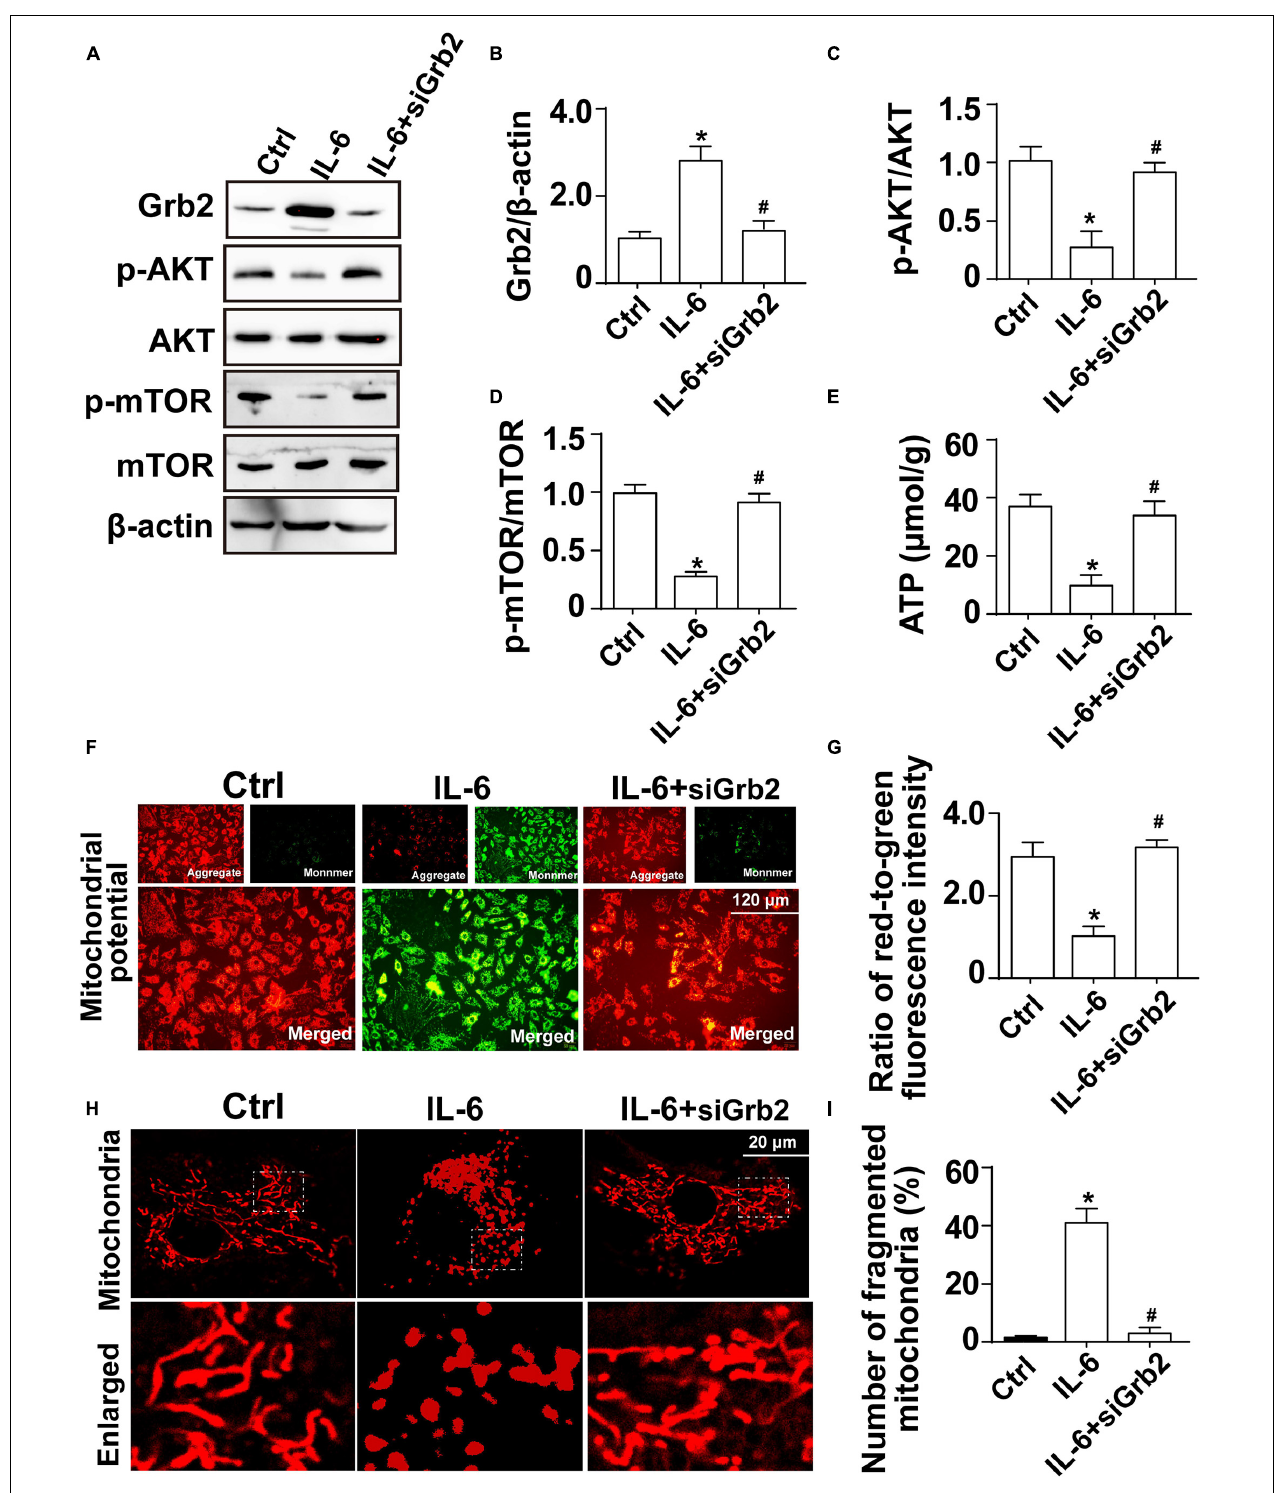
FIGURE 7 | Exogenous IL-6 mediates cardiomyocyte mitochondrial damage and bioenergetics impairment through inhibition of the Akt/mTOR signaling pathway. (A–D) Cardiomyocytes were treated with exogenous IL-6. Then, the protein expression of Grb2, p-Akt, and p-mTOR, respectively, was measured through western blots. (E) The levels of intracellular ATP production were measured through Enhanced ATP Assay Kit. (F,G) Mitochondrial membrane potential was determined through JC-1 probe. The ratio of red-to-green fluorescence intensity was measured to reflect the alterations of mitochondrial membrane potential. (H,I) Immunofluorescence of mitochondria. Cardiomyocytes were treated with exogenous IL-6. * p < 0.05 vs. control group, # p < 0.05 vs. IL-6 group.